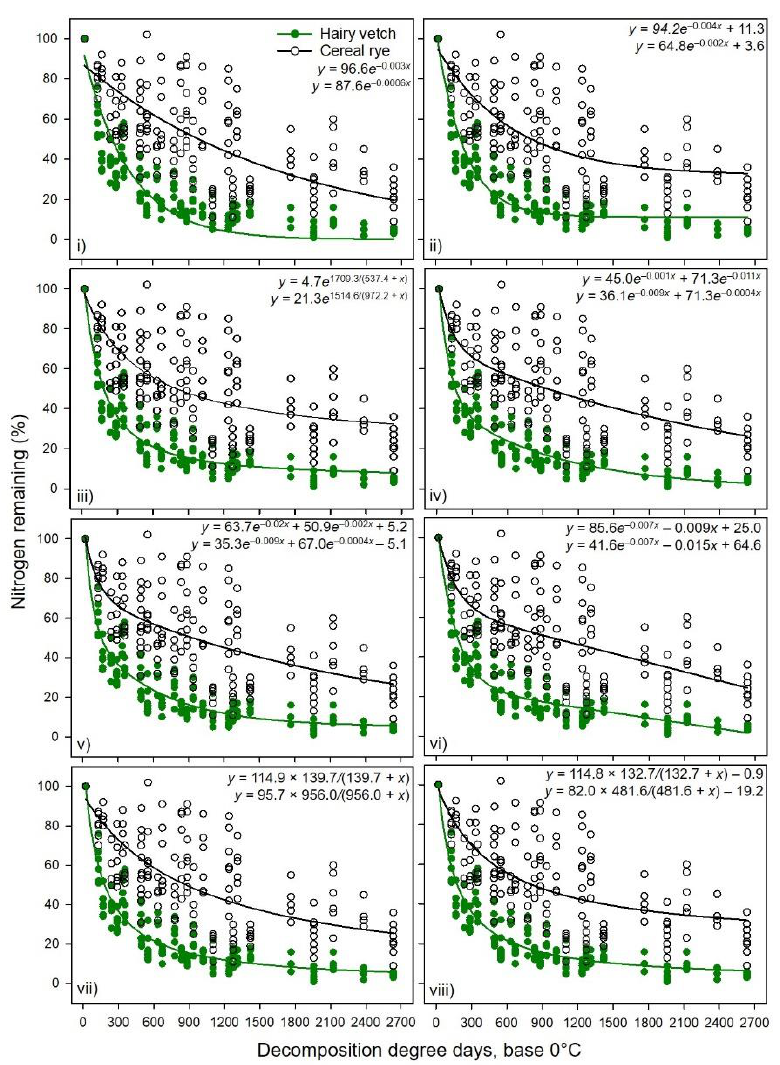
Figure 2. Exponential and hyperbolic decay models explaining percent nitrogen remaining of hairy vetch and cereal rye cover crop aboveground residue against cumulative decomposition degree days at 0 °C base temperature. ( i ) Two-parameter single exponential, ( ii ) three-parameter single exponential, ( iii ) modified three-parameter single exponential, ( iv ) four-parameter double exponential, ( v ) five-parameter double exponential, ( vi ) four-parameter single exponent with linear combination, ( vii ) two-parameter hyperbolic, and ( viii ) three-parameter hyperbolic. The upper equation represents hairy vetch and the lower cereal rye. Data were pooled from Exp. 1 and 2. All models were significant at P < 0.0001.